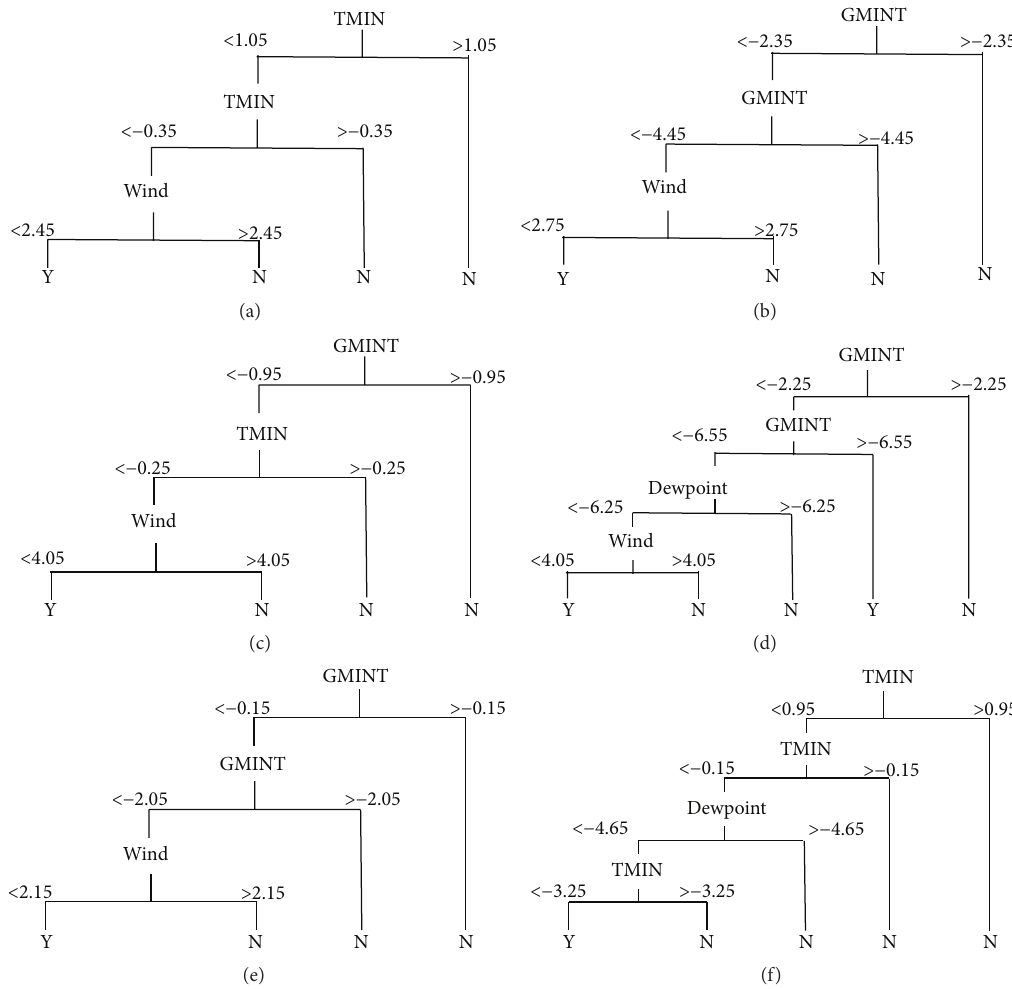
Figure 3: Determined number of nodes using the decision tree models: (a) Chuncheon (101), (b) Suwon (119), (c) Seosan (129), (d) Cheongju (131), (e) Gwangju (156), and (f) Jinju (192). GMINT: grass minimum temperature, TMIN: minimum temperature, and Wind: wind speed.